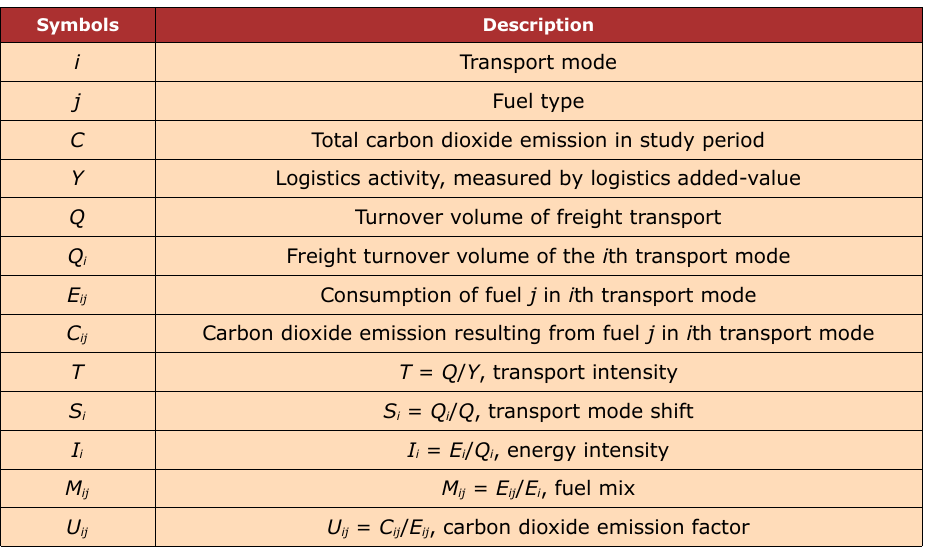
Table 1. Significance of